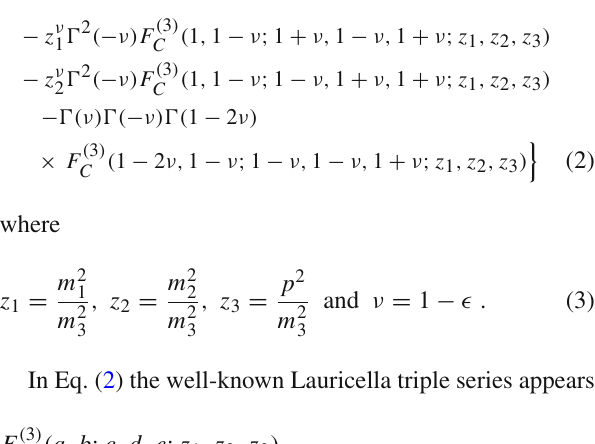
Fig. 2 Convergence region of the Lauricella triple series in Eq. (4)